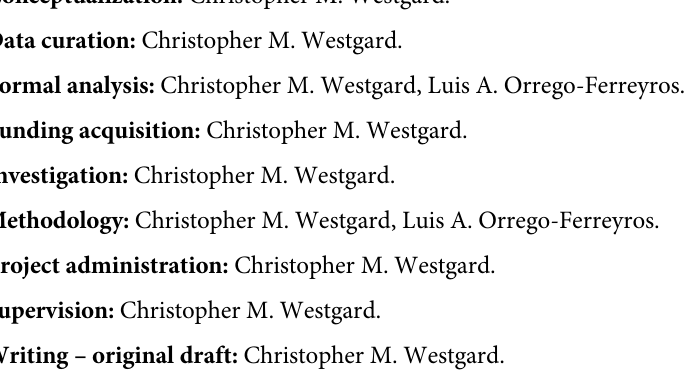
S5 Fig. CONSORT flow diagram. S6 Fig. Trial